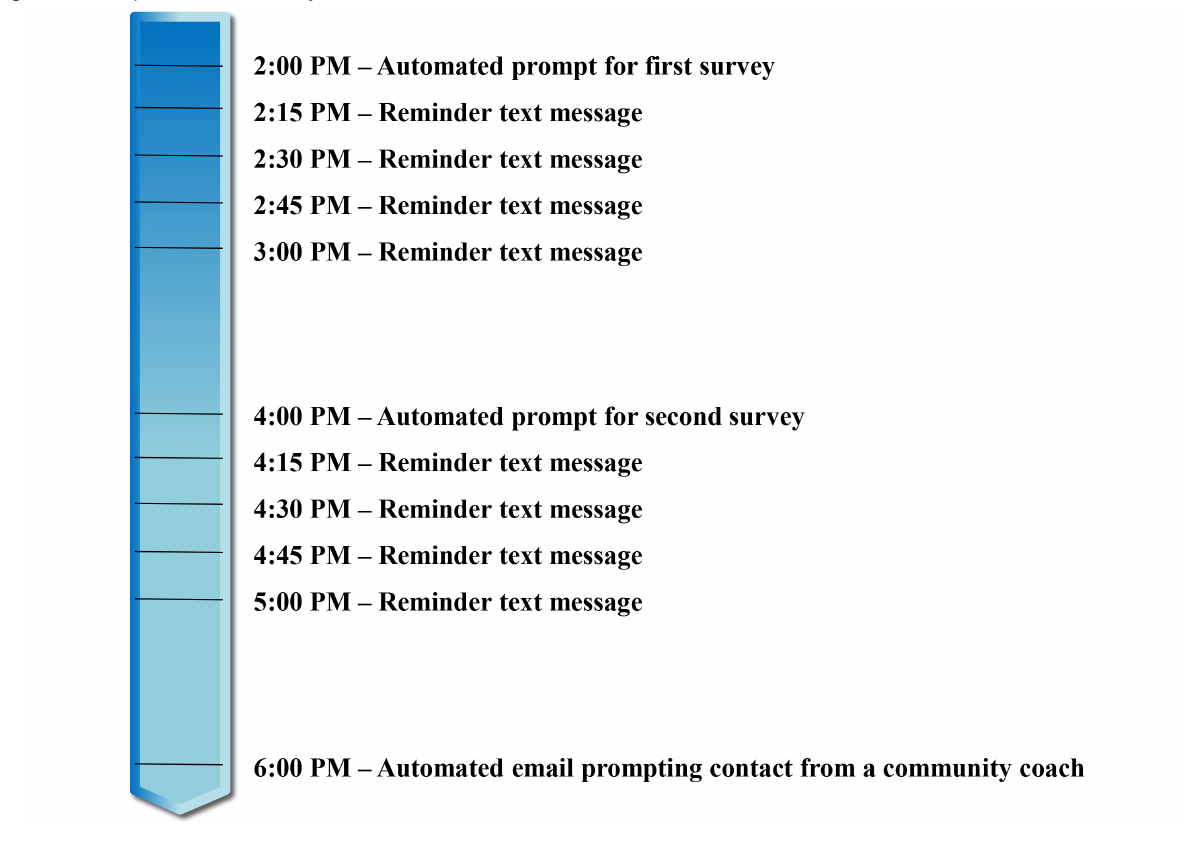
Figure 3. Example timeline of survey